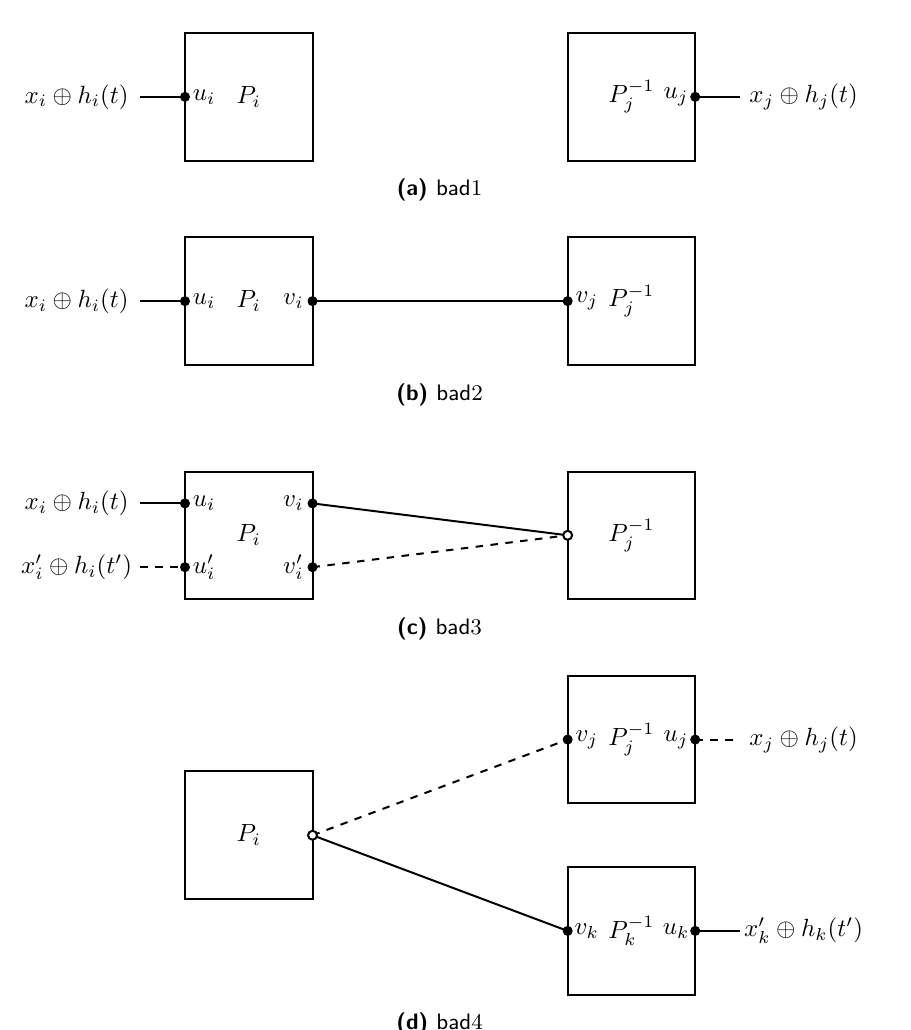
Figure 2: Bad events bad 1, bad 2, bad 3 and bad 4. Black dots represent values fixed by permutation queries, while white dots are “free”. Two distinct dots on each side do not necessarily correspond to distinct